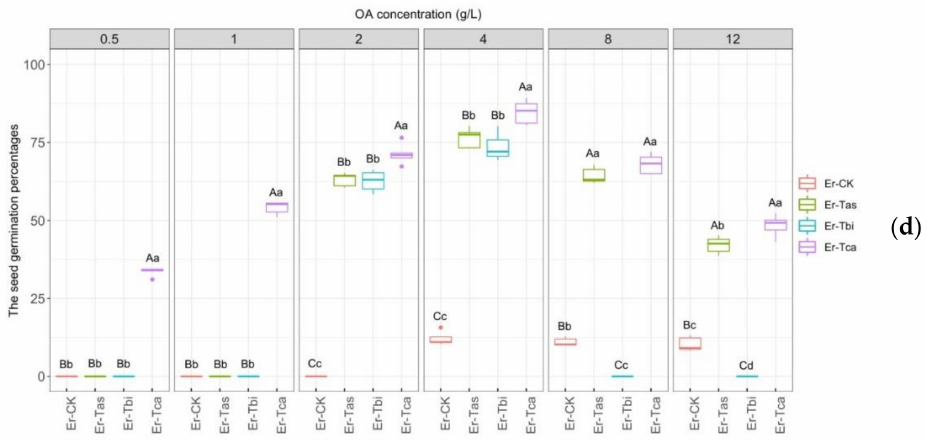
Figure 5. The effect of different fungal strains on seed germination in orchids 60 days after cultivation. ( a ) The growth index (GI) values of C. mannii with Tca (Cm-Tca), Tas (Cm-Tas), Tbi (Cm-Tbi), and CK (Cm-CK). ( b ) The GI values of E. radicans with Tca (Er-Tca), Tas (Er-Tas), Tbi (Er-Tbi), and CK (Er-CK). ( c ) The germination percentages of C. mannii with Tca (Cm-Tca), Tas (Cm-Tas), Tbi (Cm-Tbi), and CK (Cm-CK). ( d ) The germination percentages of E. radicans with Tca (Er-Tca), Tas (Er-Tas), Tbi (Er-Tbi), and CK (Er-CK). In each panel, strains with same letters are not significant; strains with different capital letters are extremely significantly different ( p < 0.001) and lowercase letters are significantly different ( p < 0.05) based on Tukey